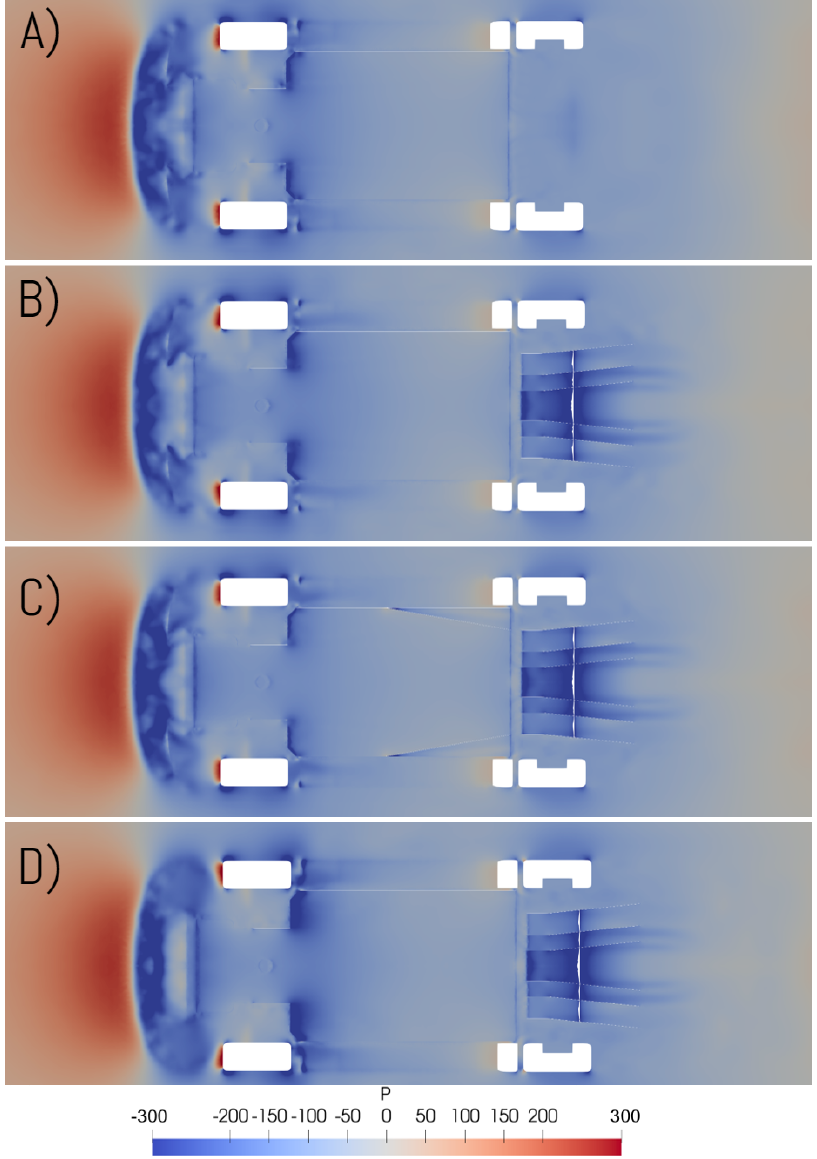
Figure 20. Pressure distribution on the XY-plane of ( A ) baseline, ( B ) Venturi diffuser, ( C ) Venturi skirts, and ( D ) Venturi frontal configurations. Units are